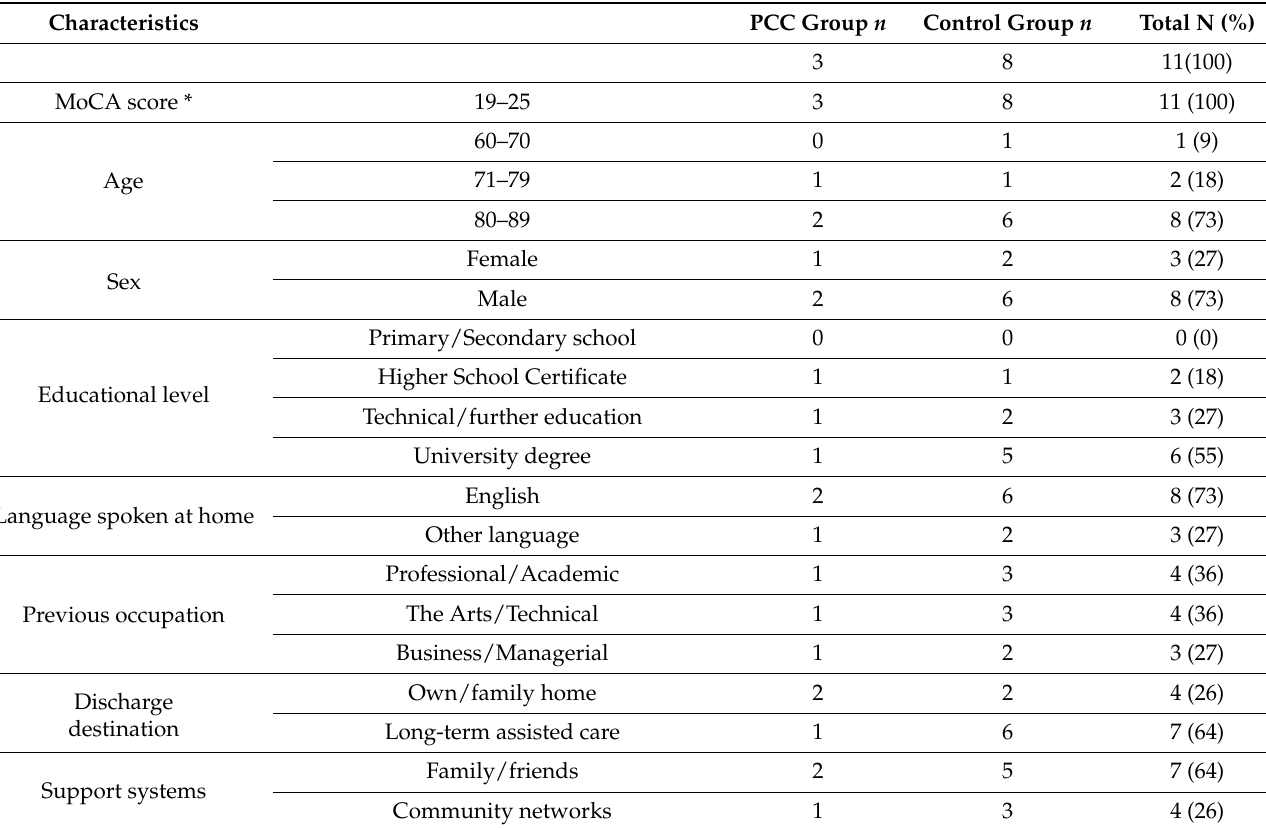
Table 2. Persons with dementia characteristics ( n =